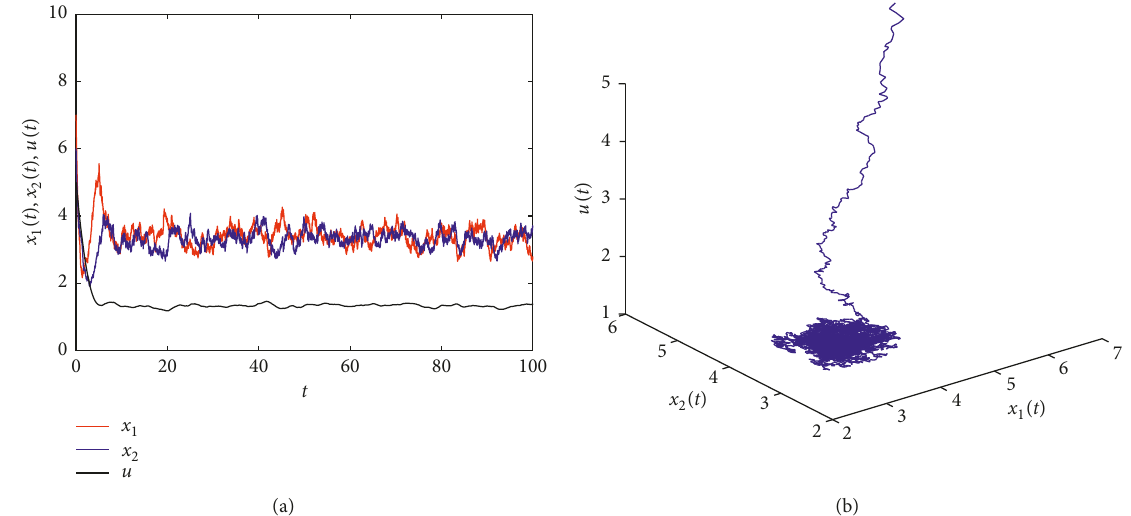
Figure 1: (a) Time series diagram of ( x